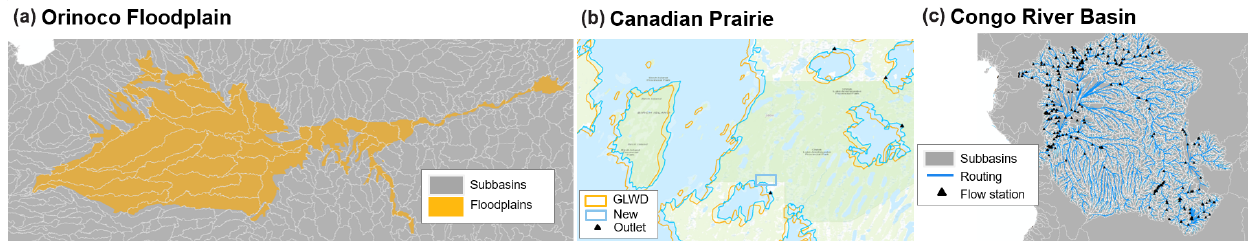
Figure 4. Some examples of WWH version 1.3 details in describing hydrography at local and regional scale from supporting GIS layers: (a) subbasins of the Orinoco River defined as a connected floodplain; (b) adjustment of lake areas (New) from merging several data sources (see Sects. 2.1 and 3.1) and the original GLWD in the Canadian Prairie; (c) river routing and access to flow gauges in the Congo River basin.